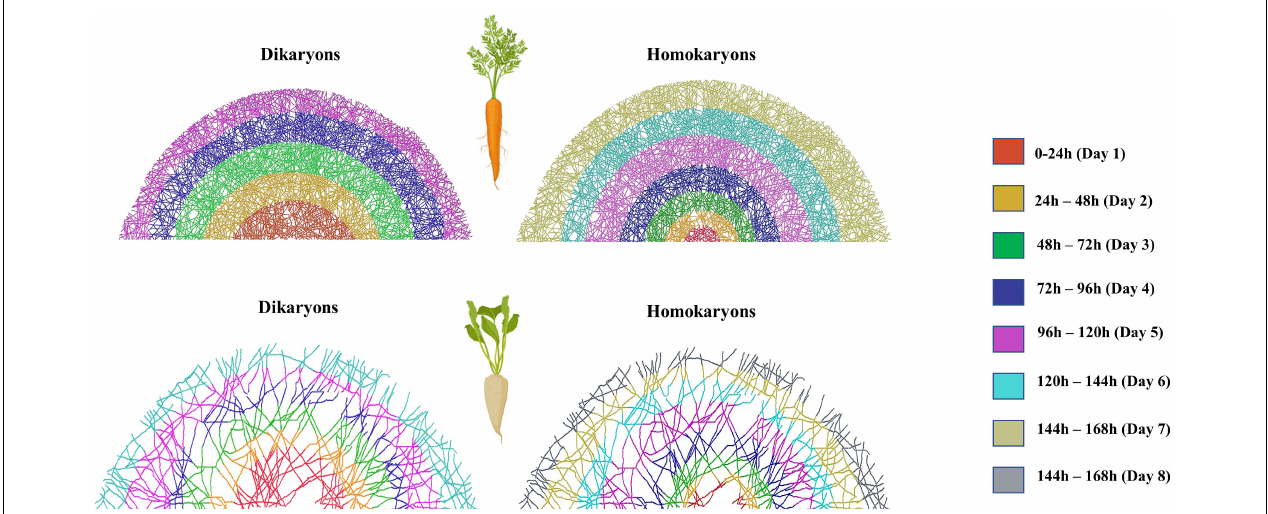
FIGURE 10 | Exploration speed (time it takes for the hyphae to reach the edge of the hyphal compartment) variation between dikaryotic and homokaryotic strains of Rhizophagus irregularis when growing with (A) Daucus carota and (B) Cichorium intybus root organ culture. Different colors indicate different distance classes. Fewer color categories correspond with faster exploration speed. Dikaryotic strains exhibited faster exploration speed compared to homokaryotic across hosts. This image was created using Adobe Photoshop version 22.1.1. based on the hypha exploration speed (GSPEED). The schematic representation of the mycelium is an average representation based on the replicates per host plant species and nuclear